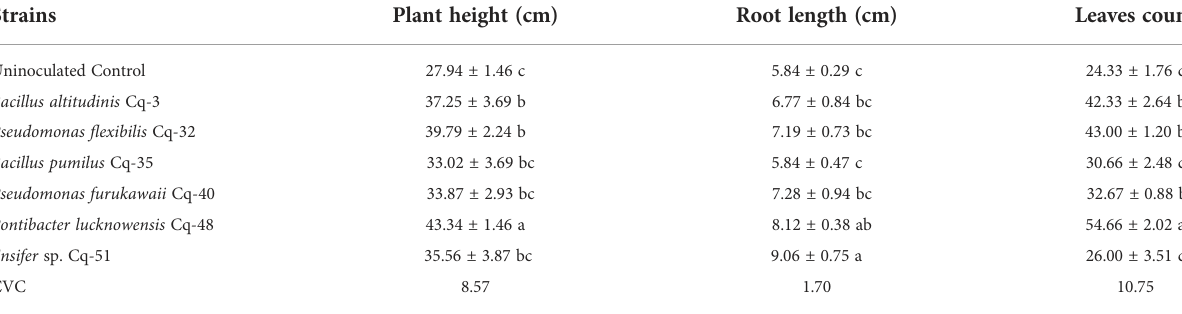
TABLE 7 Promotion of plant height, root length, and leaves count of quinoa through inoculation with phosphate solubilizing bacterial strains under pot trial. Strains Plant height (cm) Root length